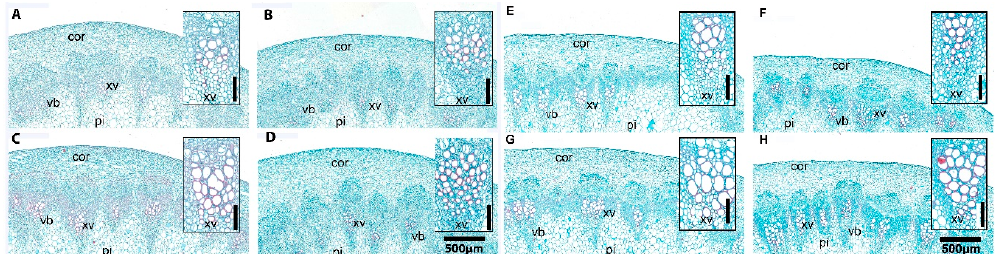
Figure 10. Transections of two rapeseed stem affected by the application of melatonin and salt stress at flowering stage. ( A – D ): Yangyoushuang2, ( E – H ): Xiangyouza553. ( A , E ): non-NaCl stress + 0 µM melatonin (control). ( B , F ): NaCl-stress + 0 µM melatonin. ( C , G ): non-NaCl stress + 50 µM melatonin. ( D , H ): NaCl stress + 50 µM melatonin. Cor: cortex, phv: phloem vessels, xv: xylem vessels, vb: vascular bundle, pi: pith. Bar in the small rectangle = 100 µm.